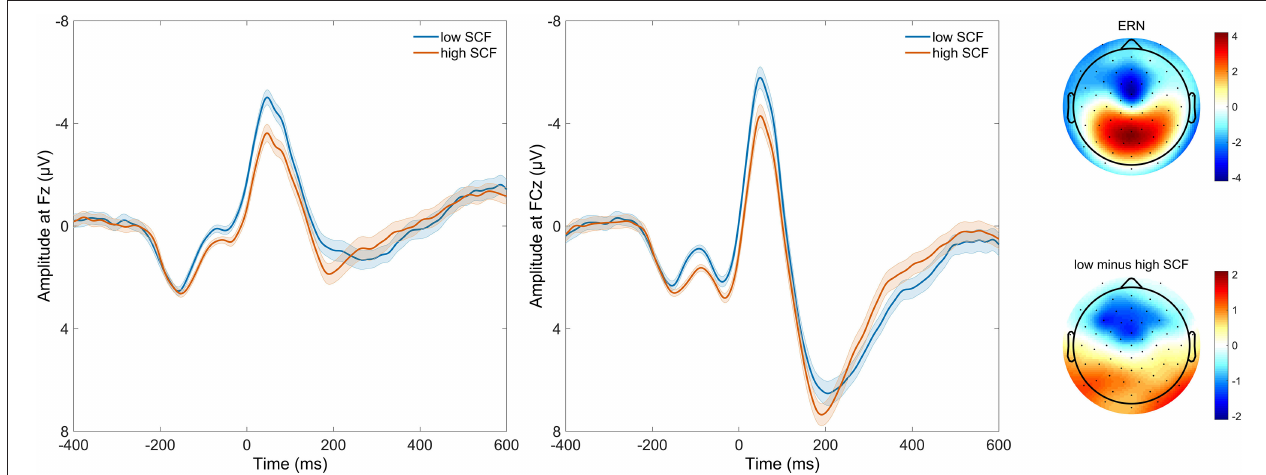
FIGURE 2 | Time course of response-locked EEG activity at electrodes FCz and Fz, and scalp distribution of response-locked EEG activity as well as difference in EEG activity between high and low number of self-control failures. Grand average event-related potential (ERP) waveforms are depicted on the left, response-locked for incongruent error trials. Waveforms are, for purpose of visualization, split by median and plotted separately for those with a lower (loSCF, blue) and those with a higher amount of self-control failures (hiSCF, red). Shadows indicate the SEM. Scalp distribution of response-locked EEG activity for ERN effect at 64ms, as well as the difference in EEG activity at 64ms between those with a lower and those with a higher amount of self-control failures are depicted on the right, as split by median for visualization.